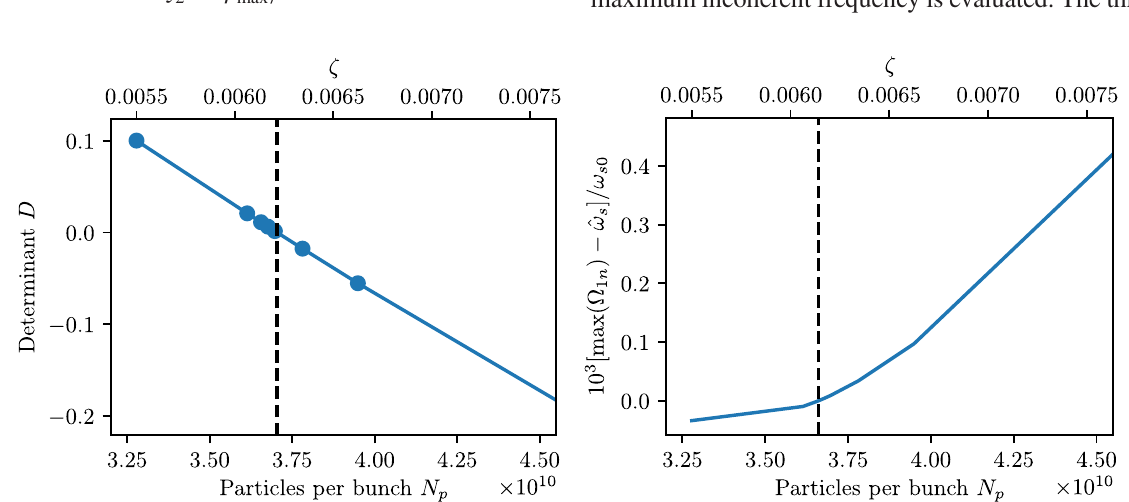
FIG. 2. Examples of the LLD threshold evaluation (shown by a vertical dashed line) in MELODY using the Lebedev equation (left) and Oide-Yokoya method (right) for η > 0 , Im Z=k ¼ 0 . 07 Ω , f